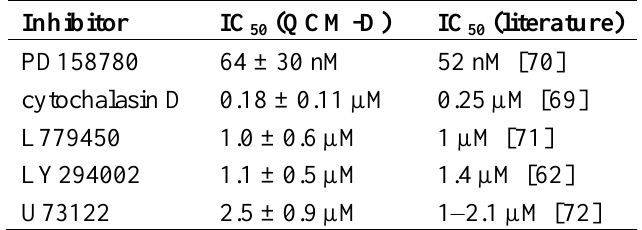
values of the 50